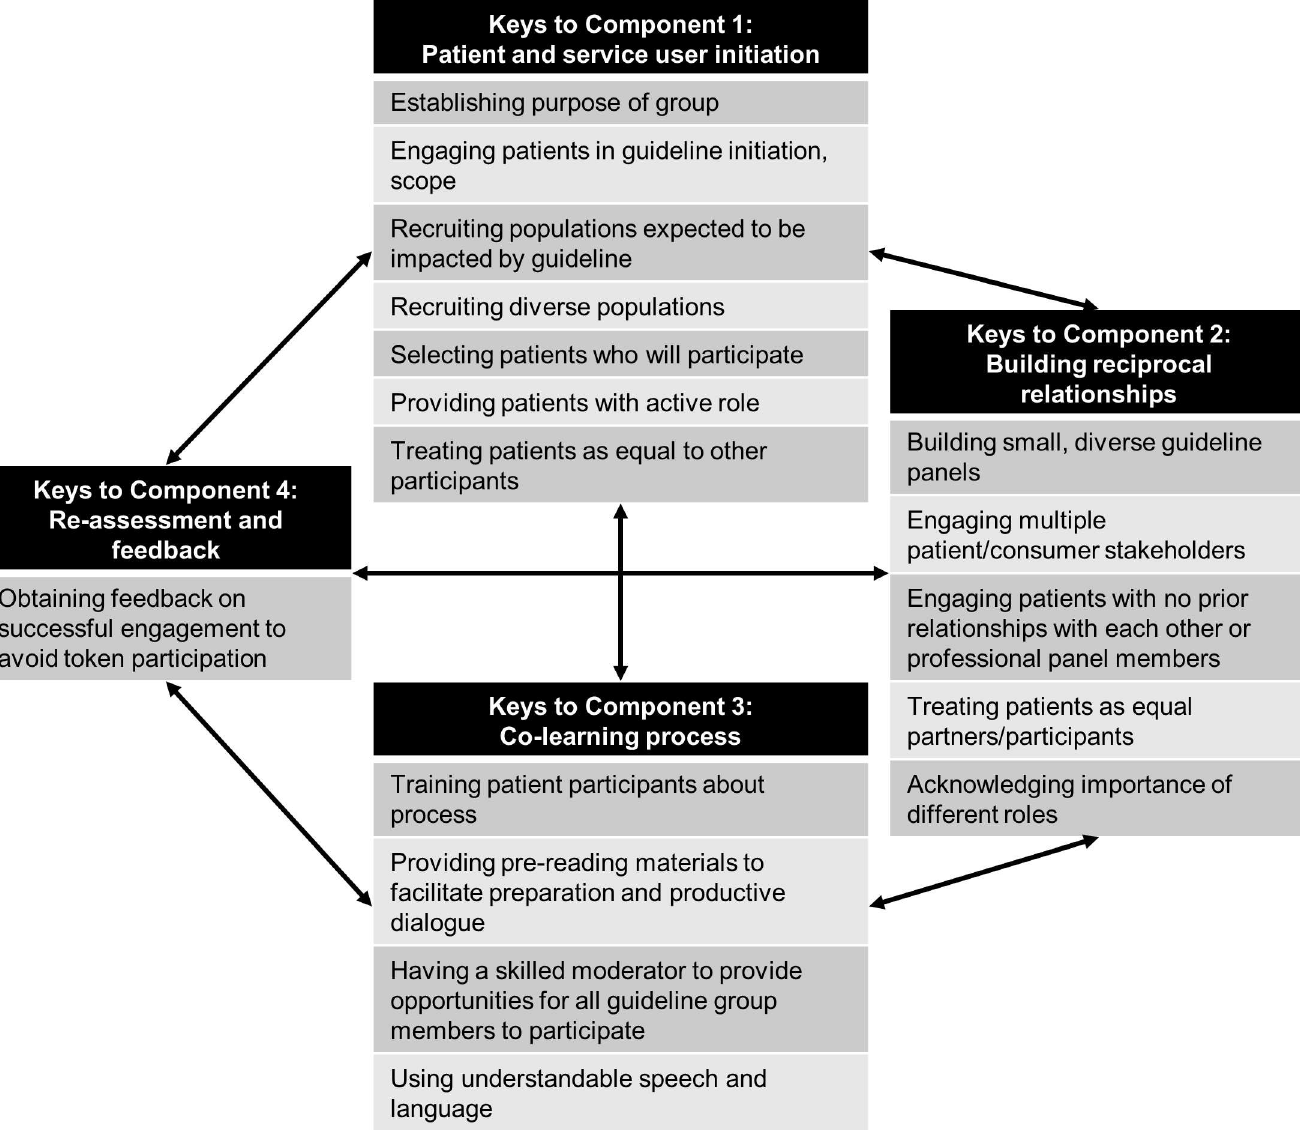
Fig 1. Key themes as they relate to integral components of patient